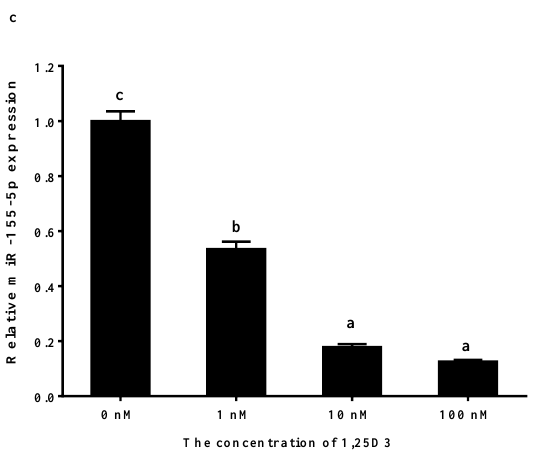
Figure 3. 1,25D3 inhibits RV-induced miR-155-5p expression in vivo and in vitro. The effect of RV challenge and VD 3 supplement on the miR-155-5p expression in the porcine jejunum ( a ), RV MOI on miR-155-5p expression ( b ), 1,25D3 on miR-155-5p expression in RV-infected IPEC-J2 ( c ). All data were expressed as means ± SD (bars represent the SD from three independent experiments). a,b,c : Means with different letters on vertical bars indicate significant differences ( p < 0.05).